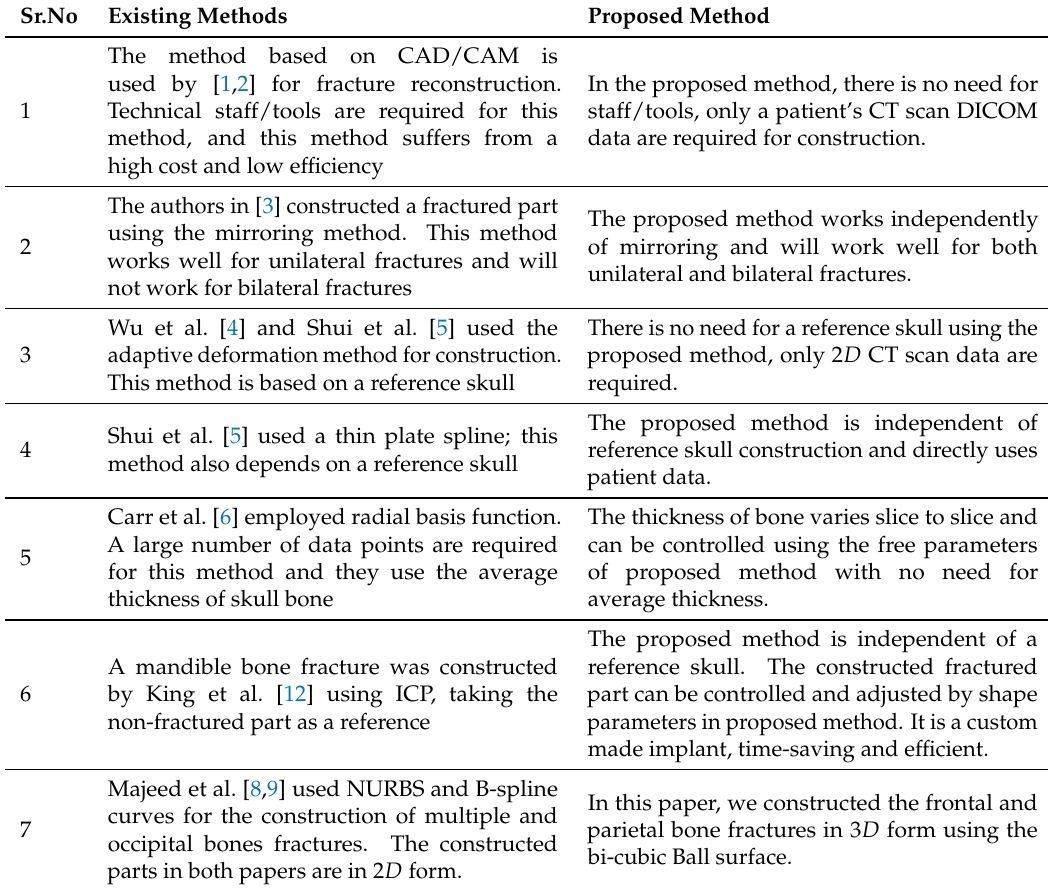
Table 1. Comparison of existing methods and proposed